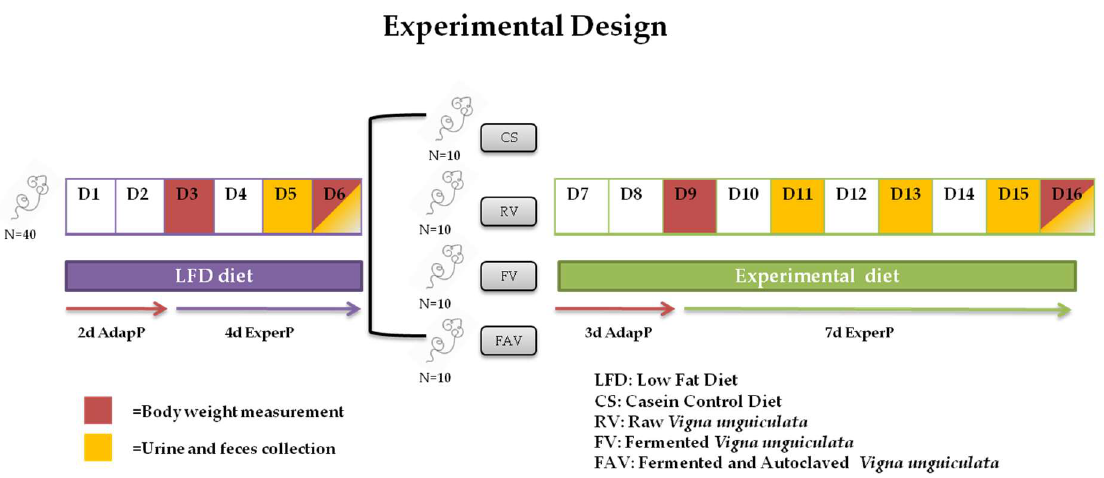
Figure 1. Experimental design of the study. D1–D16, correspond to day 1 to day 16 of the experiment; AdapP: Adaptation Period; ExperP: Experimental Period.